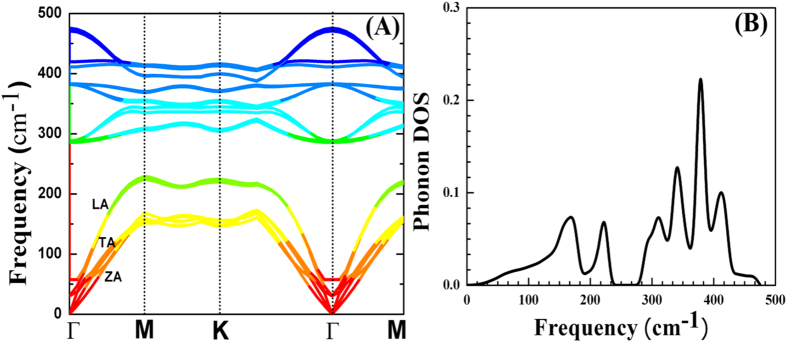
Phonon dispersion and phonon DOS for 3D flower type MoS2.The phonon modes of LA, TA and ZA phonon branches also presented.